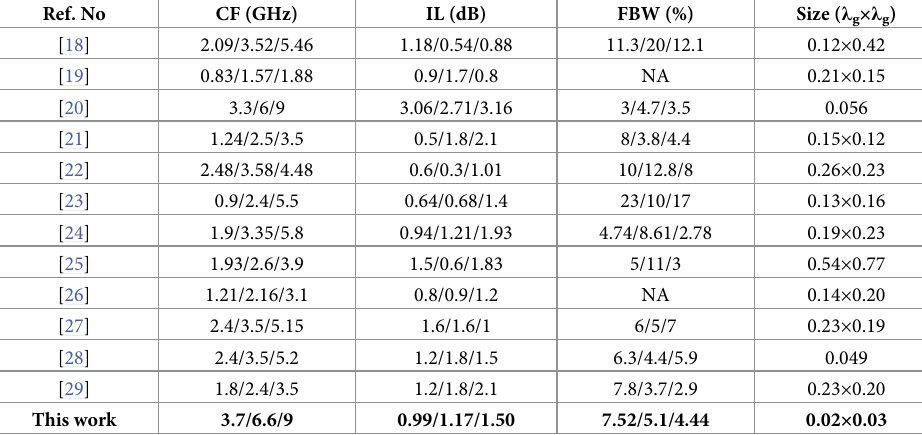
frequency response along with a fabricated photograph of the proposed tri-band filter. This shows that the fabricated filter resonates at f = 3.7 GHz, f = 6.6 GHz, and f = 9 GHz for 1 2 3 WiMAX and RFID wireless applications with the 3-dB fractional bandwidth (FBW = 7.52% 1 for the first passband, FBW = 5.1% for the second passband, and FBW = 4.44% for the third 2 3 passband), respectively. The minimum insertion loss (-20 log|S |) is 0.99 dB for 3.7 GHz, 1.17 21 dB for 6.6 GHz, and 1.50 dB for 9 GHz, while the return loss (-20 log|S |) is greater than 10 11 dB for the three passbands, respectively. The coupling between the two resonators denoted by S and the gap W between the pair of asymmetric SIRs and the input/output ports generates 1 3 five transmission zeros at 3.19 GHz, 4.71 GHz, 7.72 GHz, 8.3 GHz, and 9.91 GHz between the passbands and thus high selectivity is obtained. Moreover, the space S should be minimum 1 for achieving lower insertion loss. Furthermore, Table 7 summarizes the comparison of the Table 7. Comparison between the proposed work with other latest triband filters. Ref.